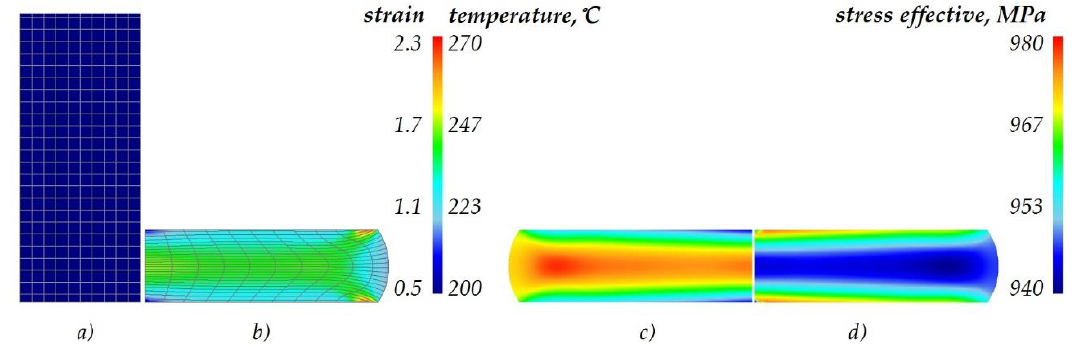
Figure 13. Numerical results of the upsetting process (half-view of the axial section): ( a ) start of the process, ( b ) effective strain, ( c ) temperature, ( d ) effective stress.